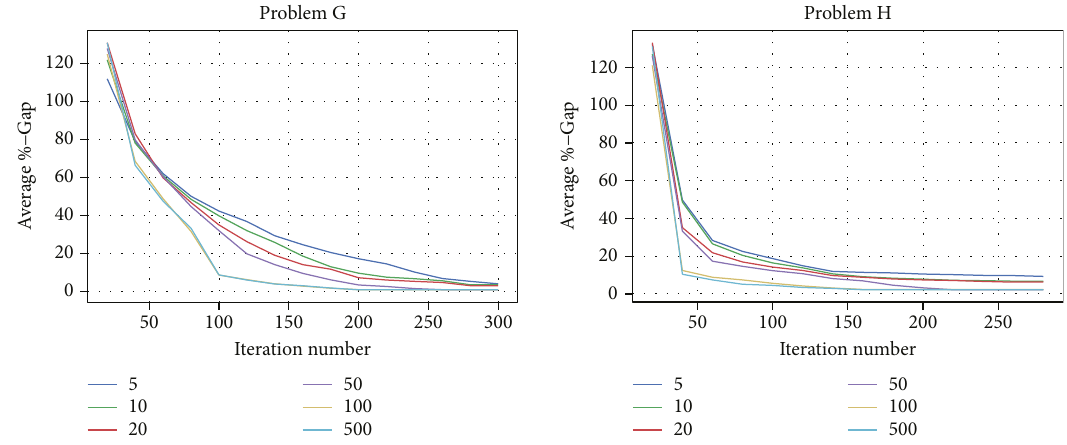
Figure 6: Convergence charts for instances of big size problems. Table 6: Spark con fi